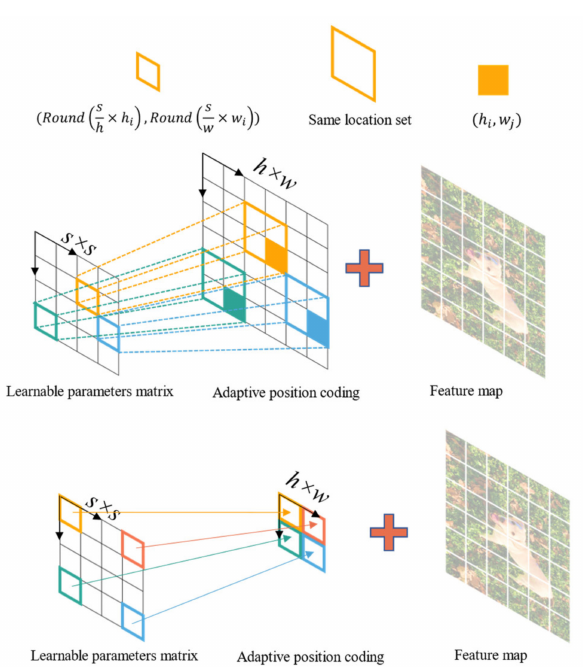
Figure 6. Schematic drawing of the implementation of adaptive 2D position